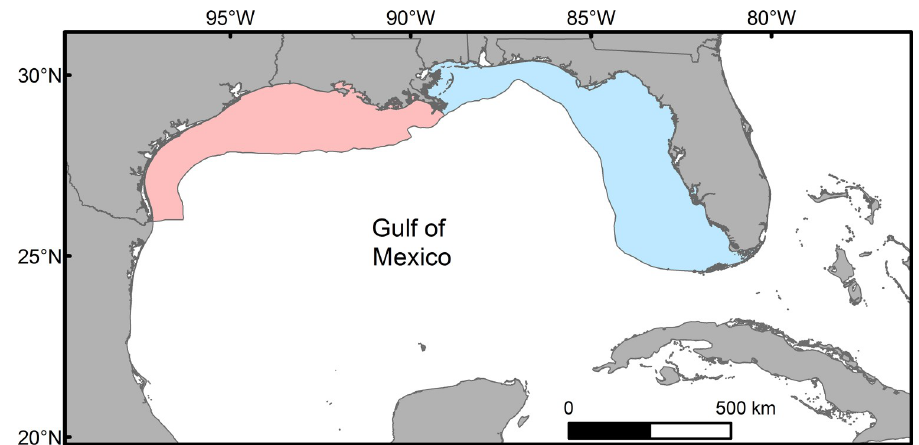
Fig 1. Shelf waters ( < 150 m) of the U.S. Gulf of Mexico. The eastern Gulf of Mexico is shown in blue, while the western Gulf of Mexico is shown in red.